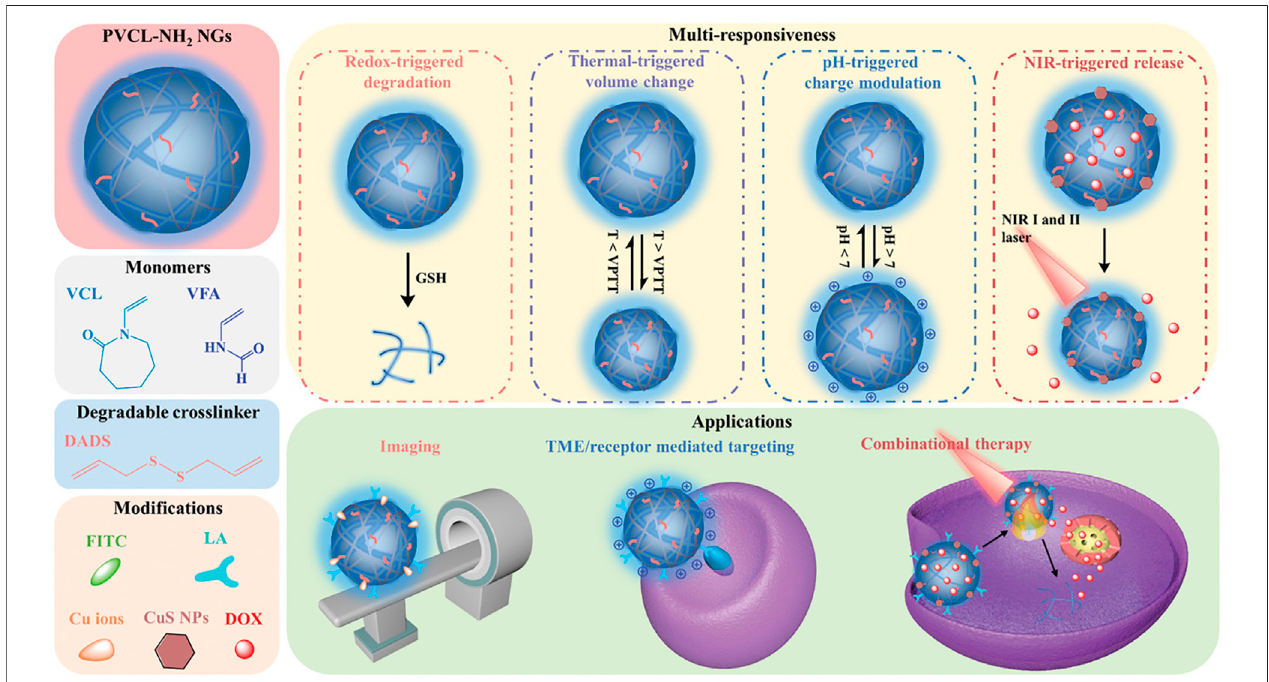
FIGURE 10 | Overview of multi-responsive PVCL-based nanoplatforms (Li X. et al., 2021). Copyright (2021) John Wiley and Sons.